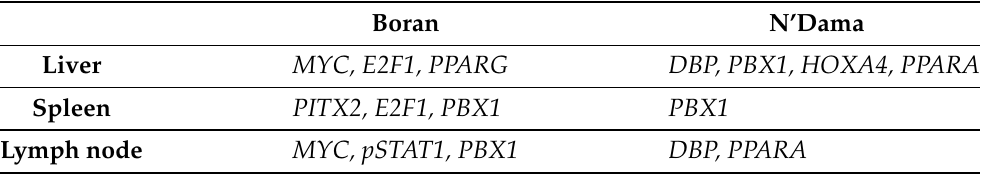
Table 2. Master regulators of the breeds Boran and